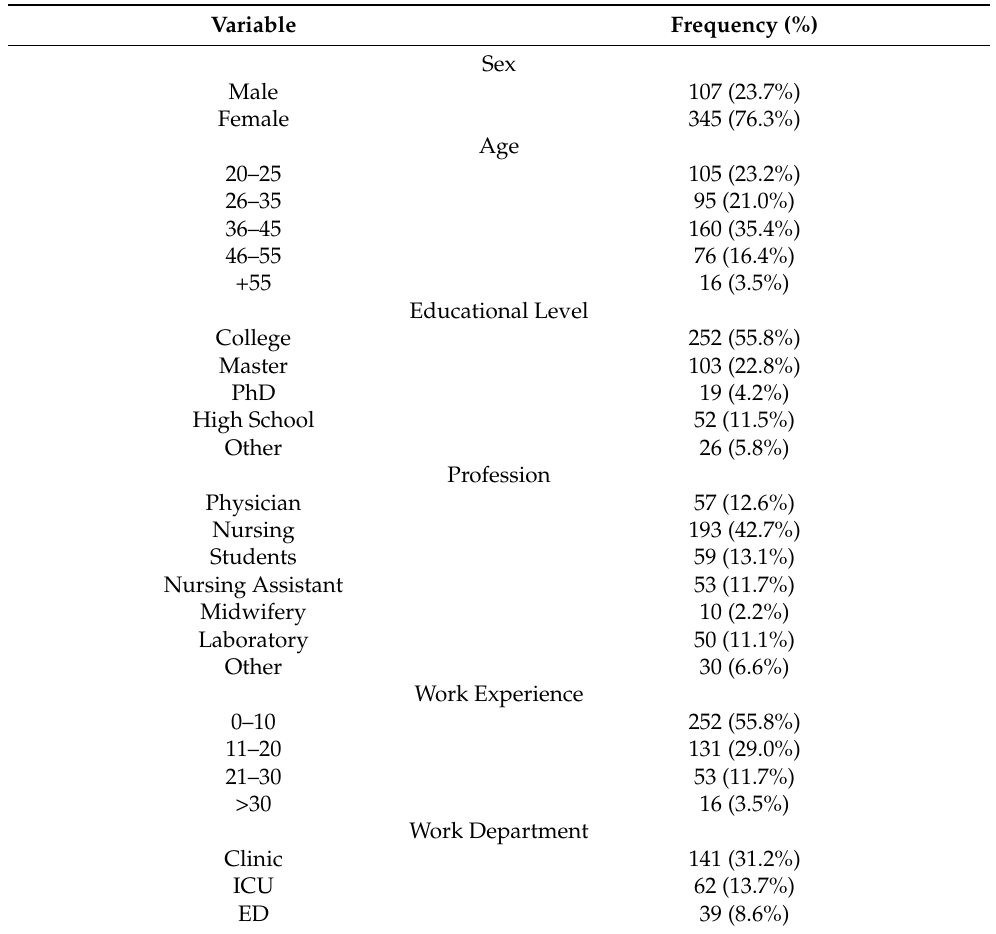
Table 1. Sociodemographic characteristics of healthcare workers in Central